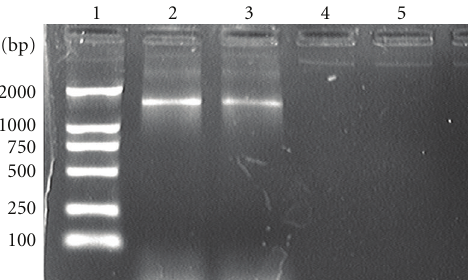
Figure 3: Transcriptional expression of LMP2A in pAd-2A trans- fected 293 cells. Lane 1: Marker DL2000; lane 2: positive control (EBV-positive LCL); lane 3: pAd-2A transfected; lane 4: pAd-LacZ transfected; lane 5: negative control (PCR on total RNA without reverse transcription).